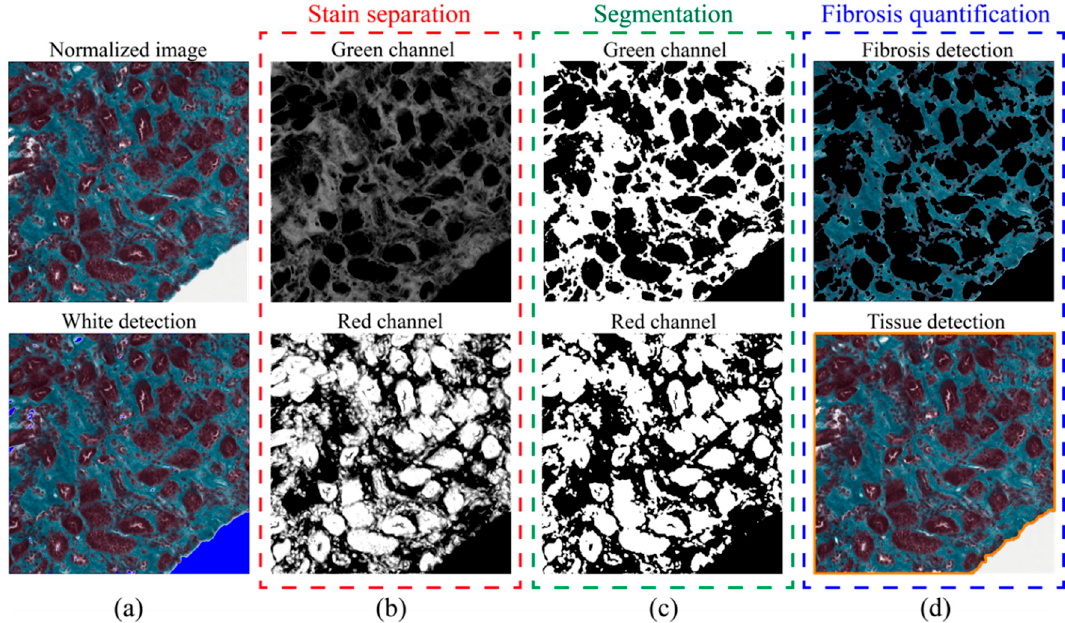
Figure 6. Steps performed by RENFAST for fibrosis segmentation. ( a ) Normalized image and white detection (in blue); ( b ) Stain separation between green and red channels; ( c ) Segmentation of green and red channels; ( d ) Fibrosis and tissue detection for interstitial fibrosis quantification.